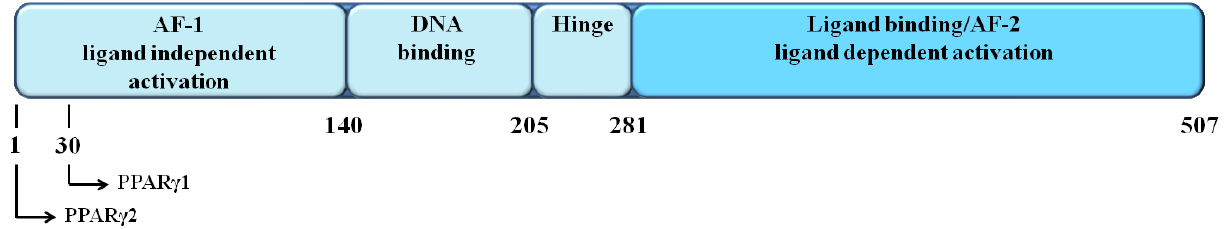
Figure 1. Schematic structure of the functional domains of the PPAR γ isoforms (transactivation function domain 1 (AF1) DNA-binding domain (DBD), ligand-binding domain (LBD) and transactivation function domain 2